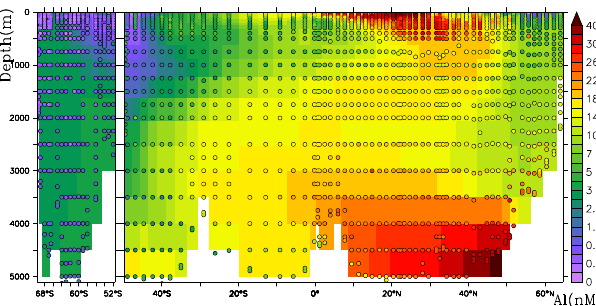
Figure 5. Dissolved aluminium concentration (nM) from RefDyn2 (simulated year 1750) along the Zero Meridian and West Atlantic GEOTRACES transect. Observations are presented as coloured dots. The contour is the Atlantic overturning stream function (OSF), only defined north of Cape Agulhas and away from 36 ◦ N where cross-land mixing through the unresolved Strait of Gibraltar does not allow for a well-defined OSF.